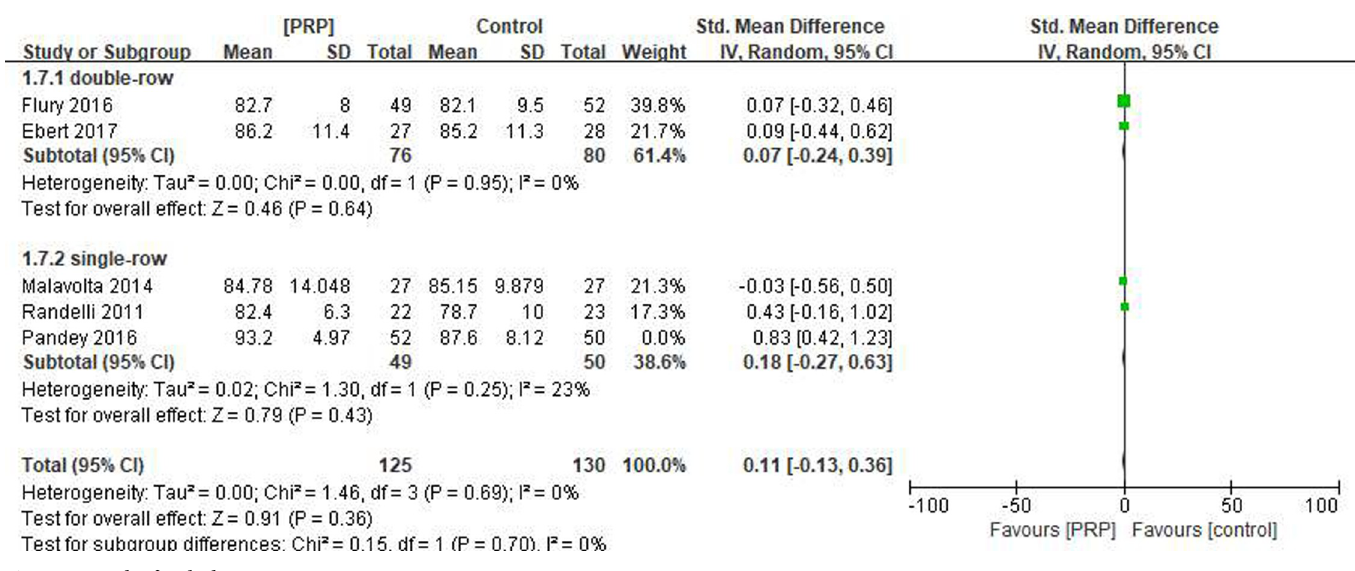
Fig 6. Forest plot for the long-term constant score.